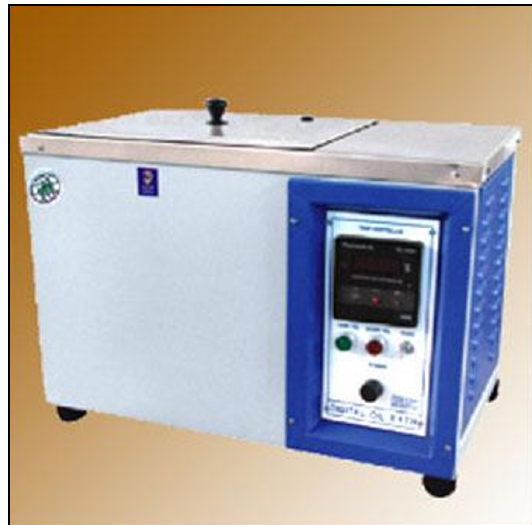
Figure 1. High Temperature Oil Bath.